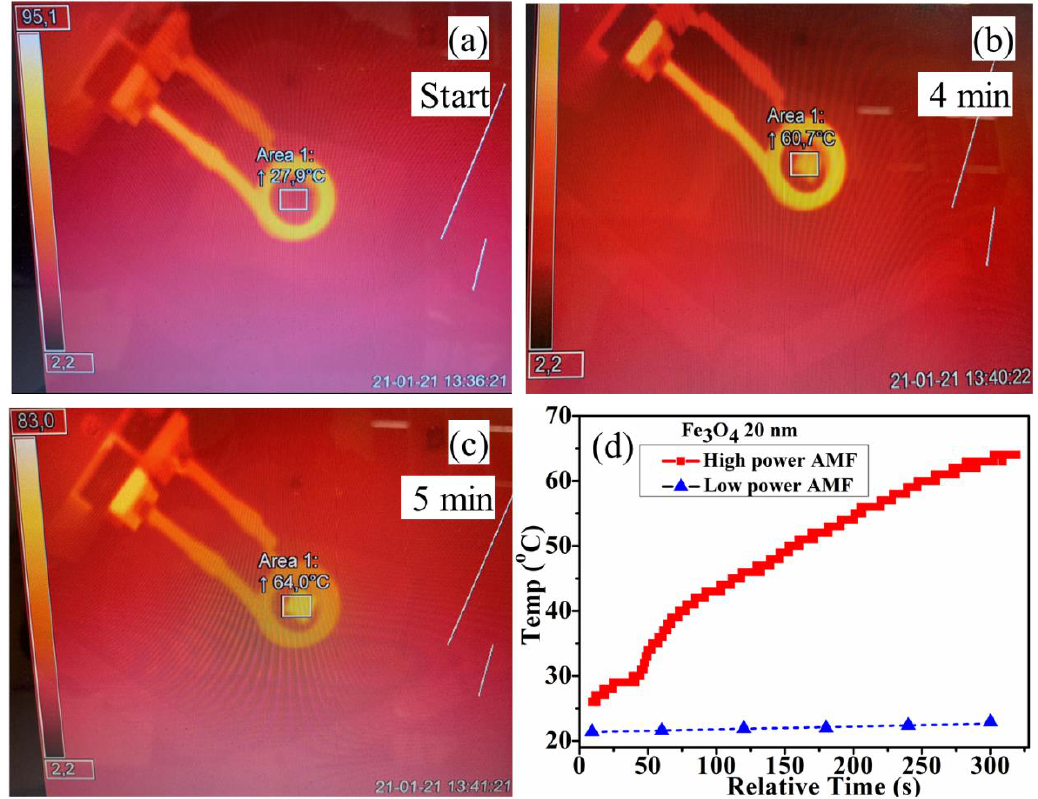
Figure 9. Experimental results of exposing solution samples (Fe 3 O 4 MNPs doped in PVA) to AMF. IR camera images taken at the start of the experiment ( a ), after 4 min ( b ) and after 5 min ( c ), tem- perature change of Fe 3 O 4 doped layers during exposure to AMF ( d